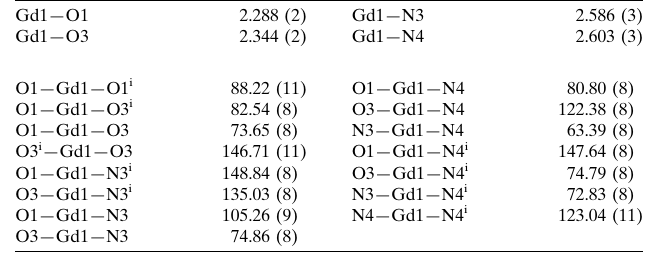
Selected geometric parameters (A˚ , (cid:3) ).